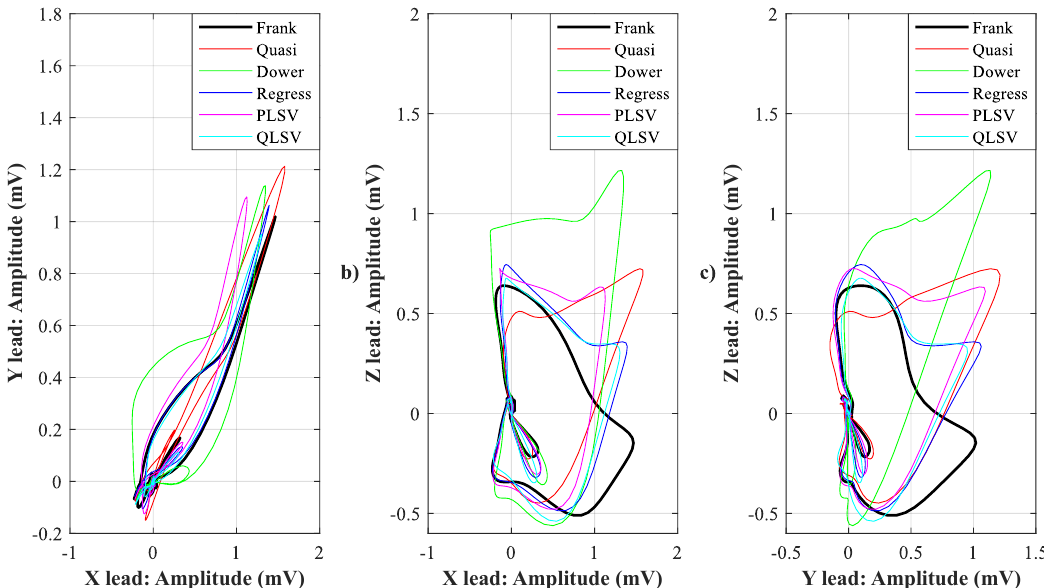
Figure 11. Comparison of transformation methods in 2-D, random patient 3. ( a ) X lead to Y lead, ( b ) X lead to Z lead, and ( c ) Y lead to Z lead.